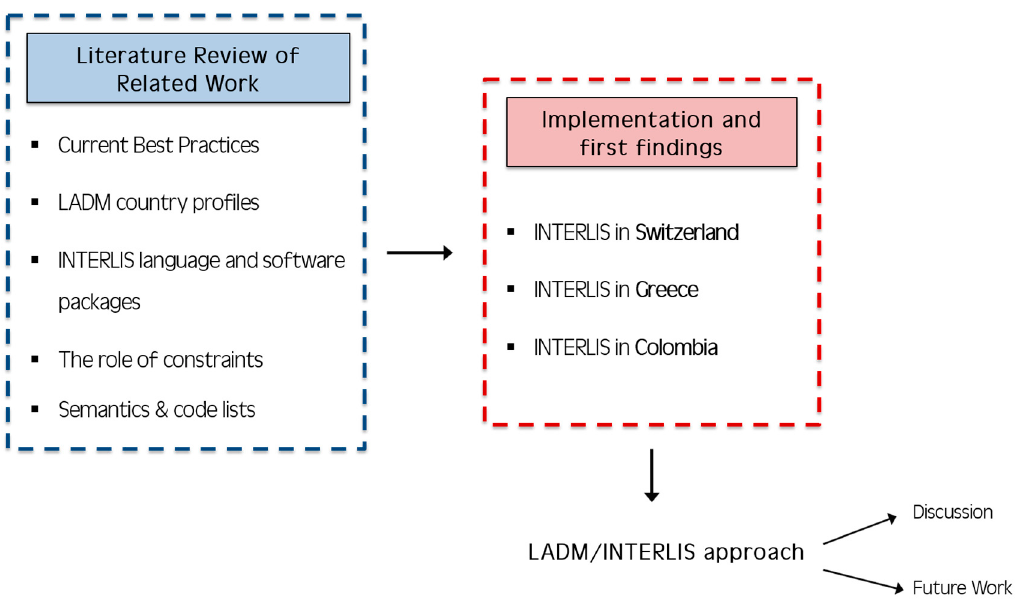
Figure 1. Methodology used to address research objectives.